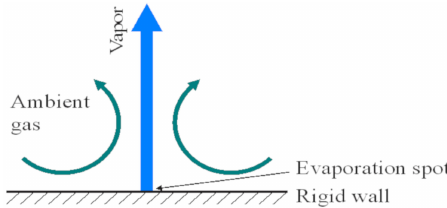
Figure A1. Gas-phase flows at